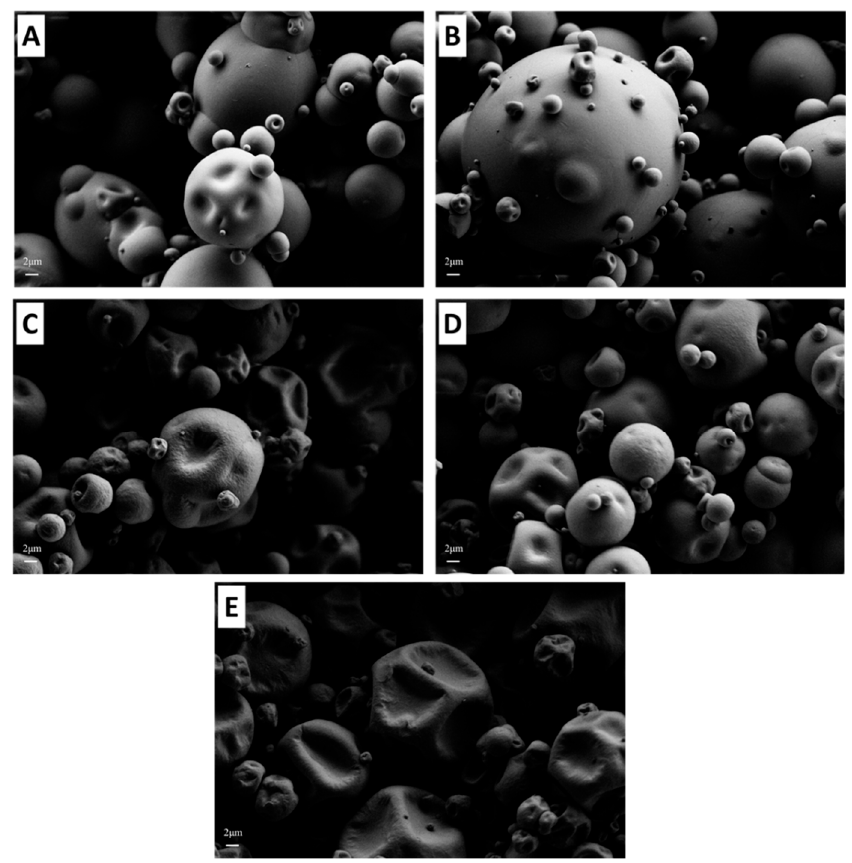
Figure 3. Scanning electron microscopy images of milk protein concentrate (MPC) 85 ( A ), MPC75 ( B ), MPC65 ( C ), MPC55 ( D ), and MPC40 ( E ) powders at 5000× magnification.